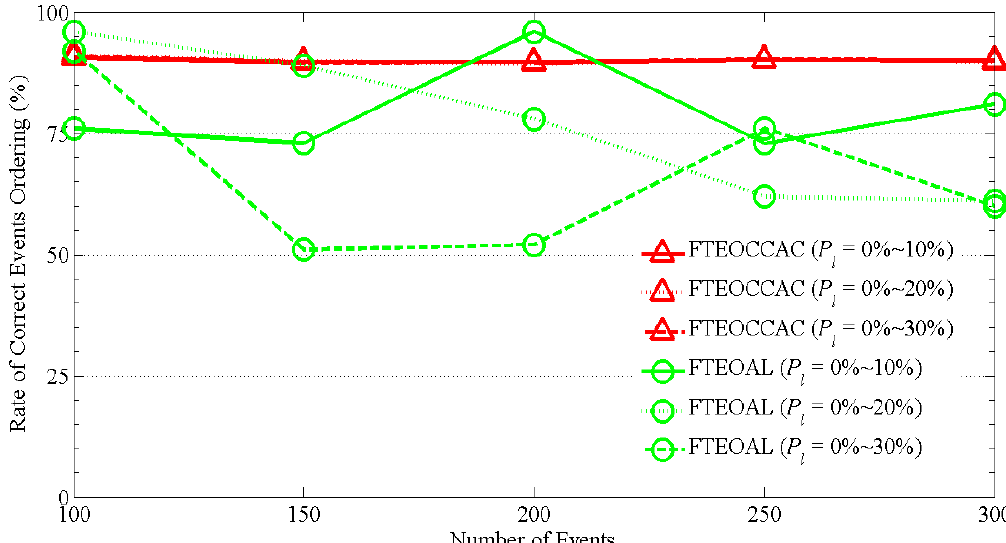
Figure 6. RC in FTEOCCAC and FTEOAL for different P l ( DTG = 100 ms, DT = 2000 ms, P d = 0-30%).